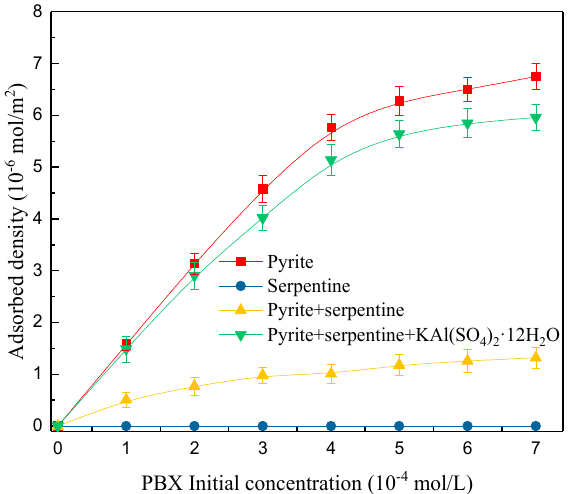
Figure 8. Adsorption isotherms of PBX on pyrite and serpentine ([serpentine] = 2g/L, [KAl(SO 4 ) 2 · 12H 2 O] = 2.5 × 10 − 3 mol/L, pH = 9.0).